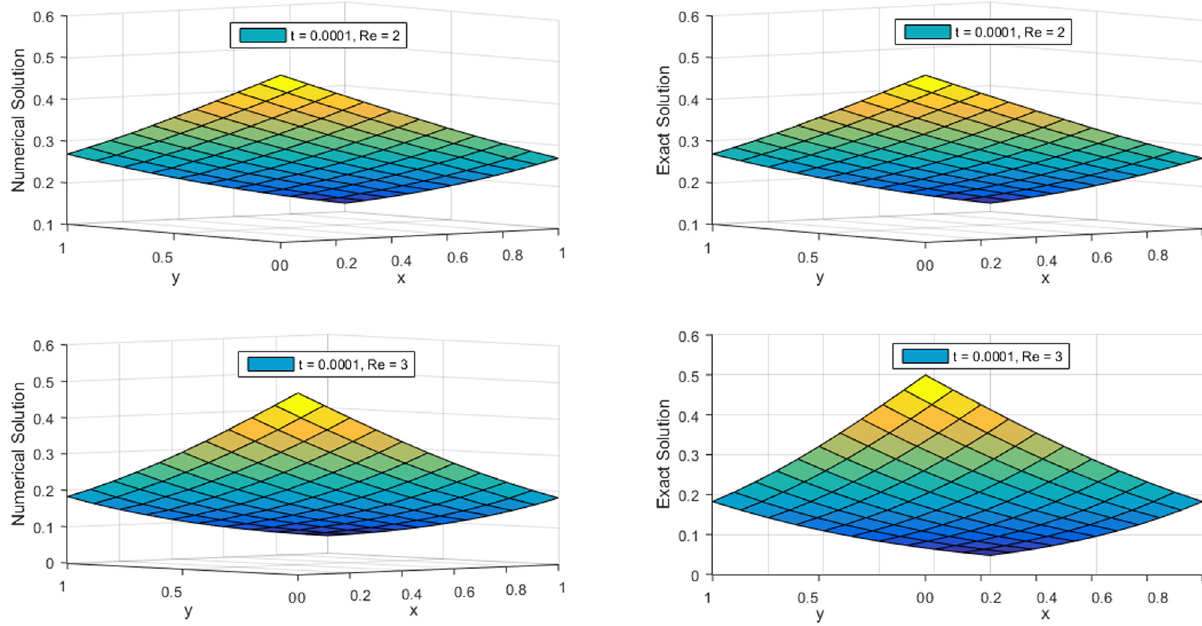
Figure 11: Graphical plot at = t 0.0001 , for Re = 2 and 3 for N = 51, = t Δ 0.0001 .